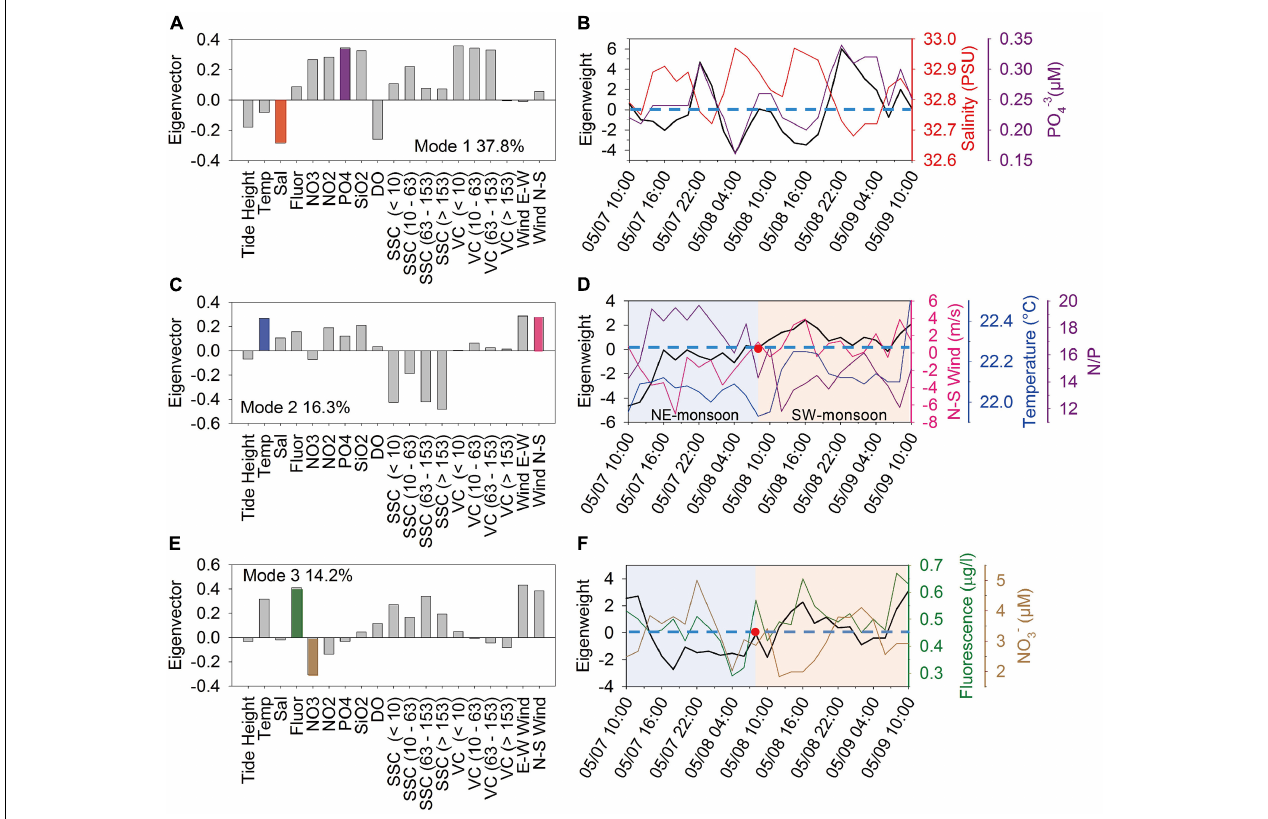
FIGURE 7 | Plots of EOF analysis result on the 19 variables in the upper water column showing (A) Mode 1 eigenvectors; (B) Mode 1 eigenweighting curve with salinity and PO 43 − as comparison; (C) Mode 2 eigenvectors; (D) Mode 2 eigenweighting curve with N-S wind, temperature, and N/P as comparison; (E) Mode 3 eigenvectors; (F) Mode 3 eigenweighting curve with fluorescence and NO 3 − as comparison (the dotted blue line shows the zero value of the eigenweightings). The red dots show the position of zero-crossing on Mode 2 and 3 eigenweighting